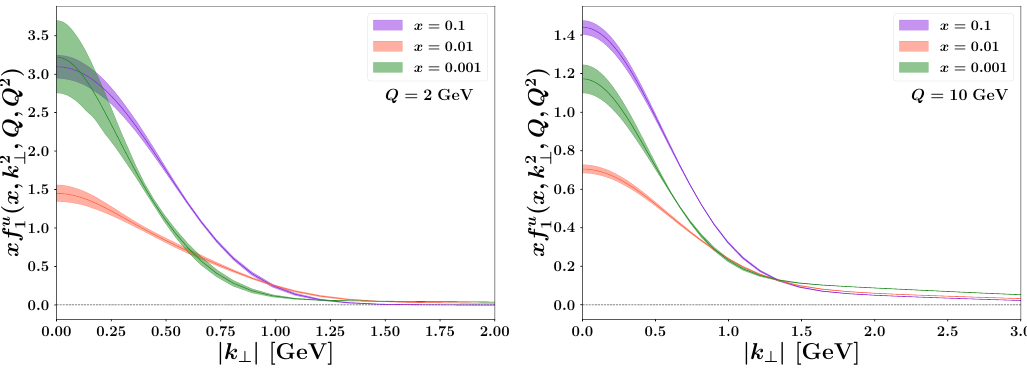
Figure 13 . The TMD PDF of the up quark in a proton at µ = √ ζ = Q = 2 GeV (left panel) and 10 GeV (right panel) as a function of the partonic transverse momentum and 0.1. The uncertainty bands represent the 68%